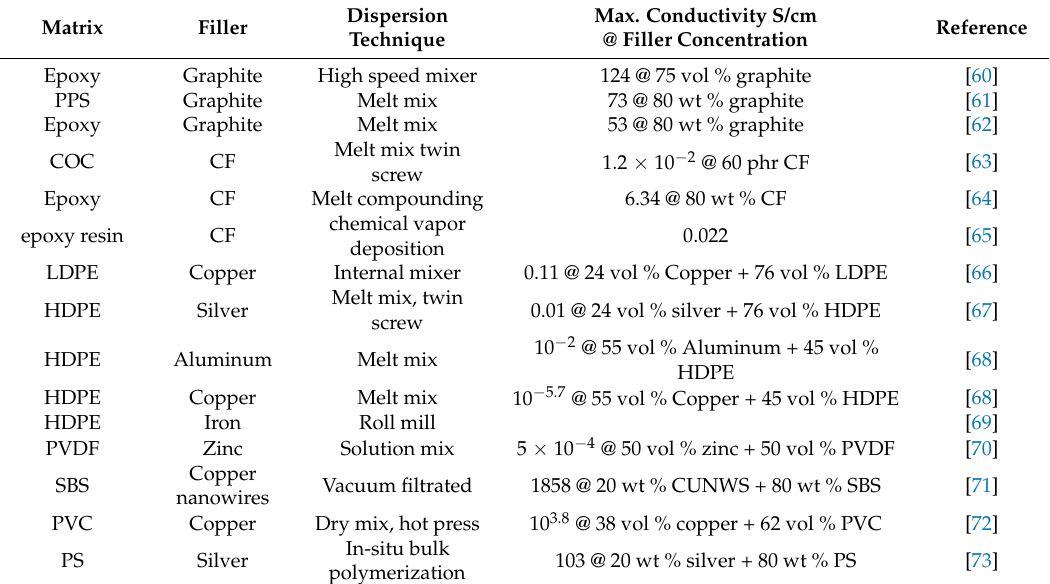
Table 2. Different dispersion techniques for the preparation of conductive